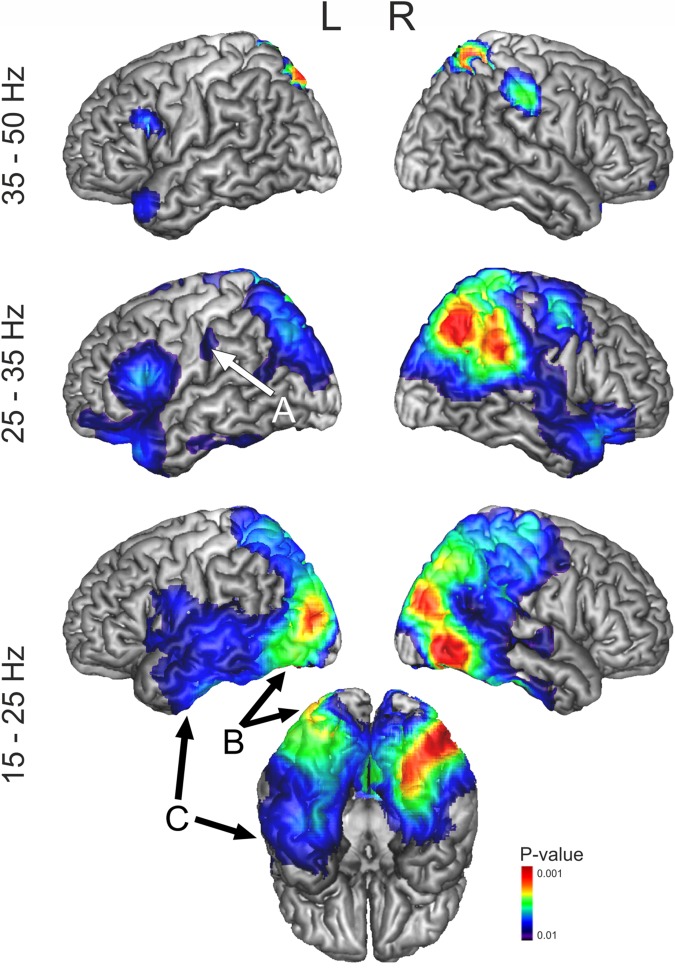
3D rendered cortical representations showing significant activity above baseline across conditions, during 500 ms post-target onset in four frequency bands (15–25 Hz, 25–35 Hz and 35–50 Hz).t-Maps are thresholded at p<0.01 (corrected). All the activations represent event related desynchronization. Significant event related desynchronization was only observed between 5–15 Hz in a region of the right fusiform gyrus that overlapped with the activity observed at 15-25Hz, at a reduced threshold (p = 0.05) and thus this frequency band was omitted from this figure, although all of the whole-brain maps can be accessed from Neurovault (http://neurovault.org/collections/1937/). Arrows indicate the locations selected for the VE analysis.